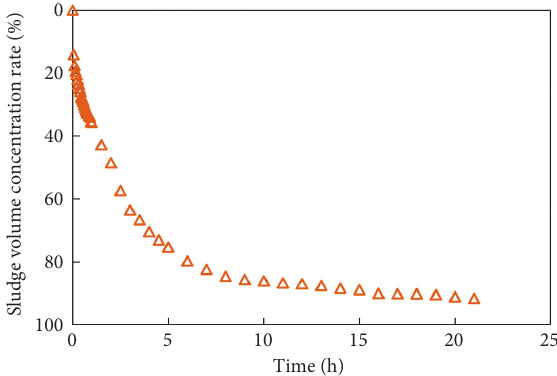
Figure 10: Sludge volume concentration rate.